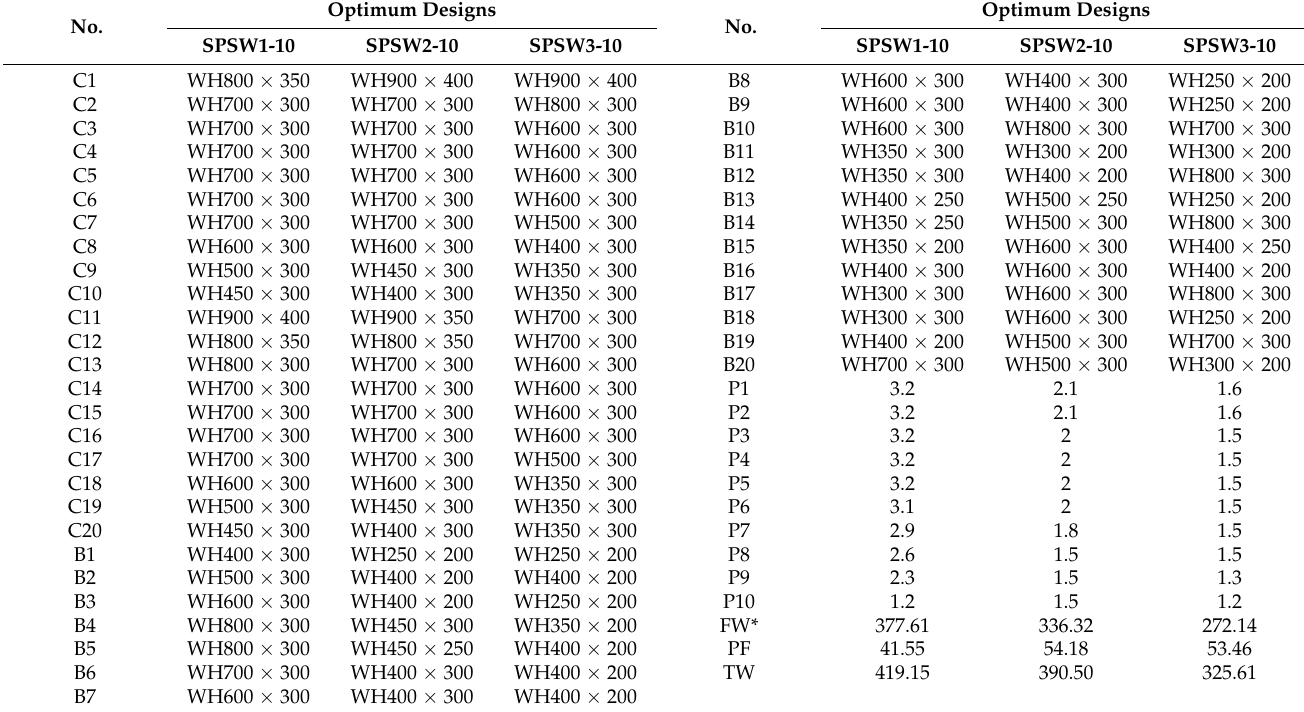
Table 8. Optimum designs of 10-story steel frame.